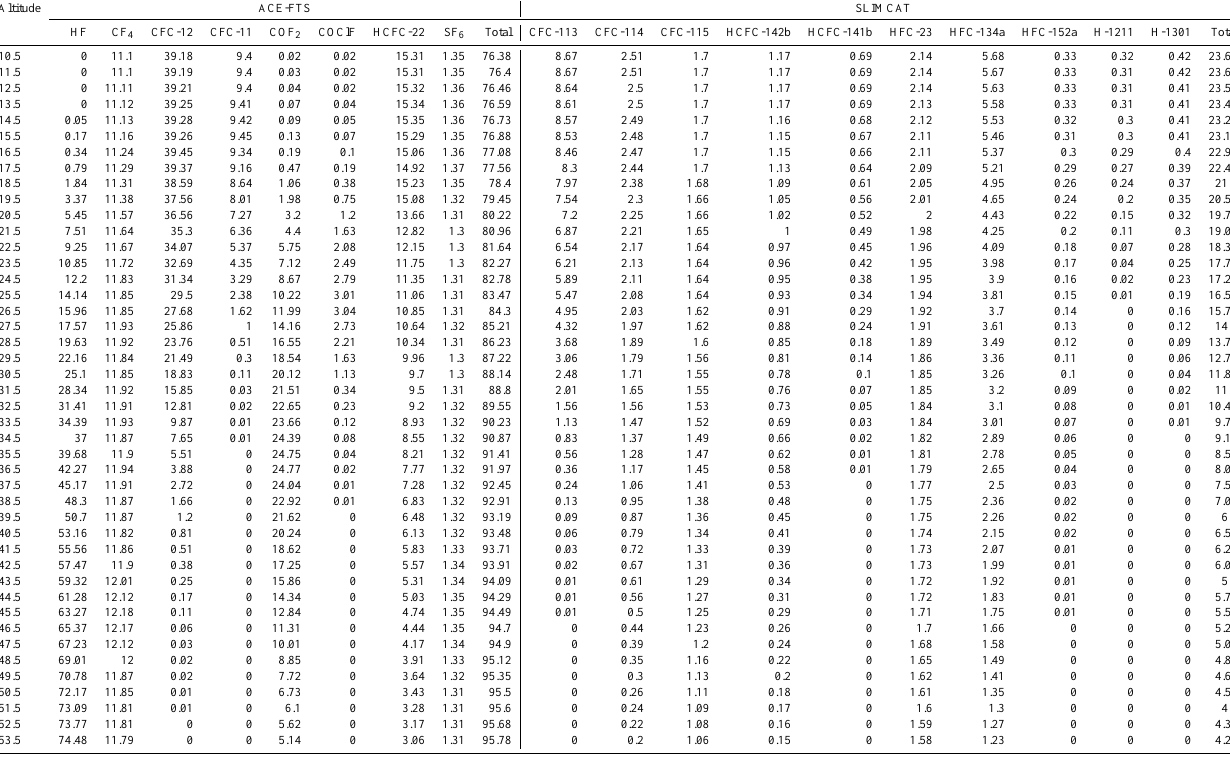
Table A2. The percentage contribution of each species to the total fluorine budget in the latitude bands between 30 ◦ N and 0 ◦ N.